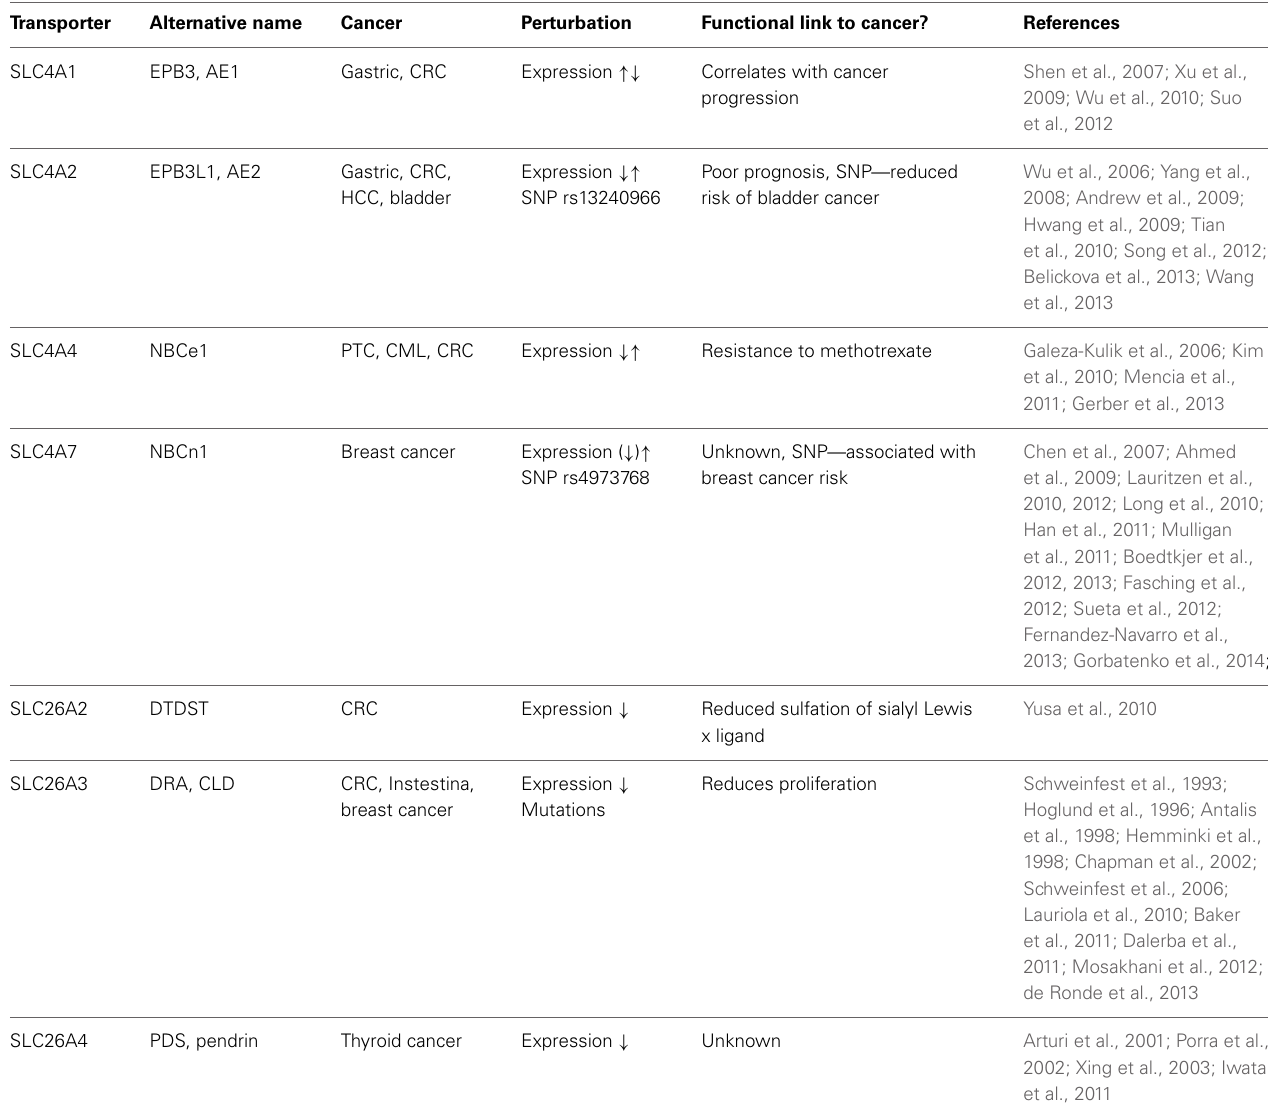
Table 1 | Summary of the reported data on HCO −